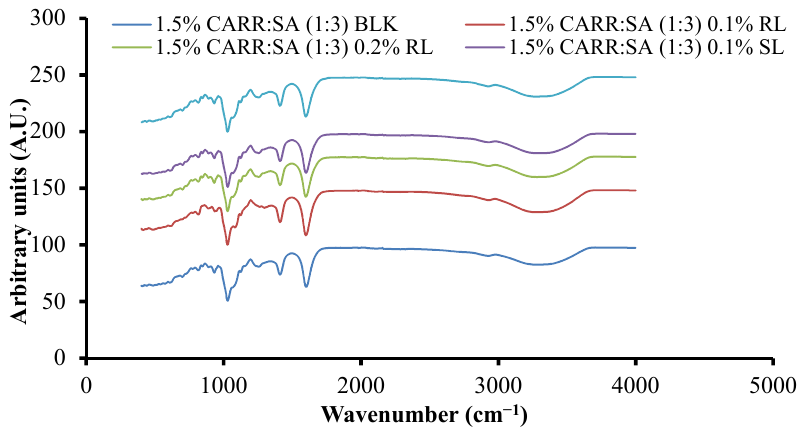
Figure 3. ATR-FTIR spectra of 1.5% CARR:SA (1:3) BLK and BSs loaded 1.5% CARR:SA (1:3) wafers.